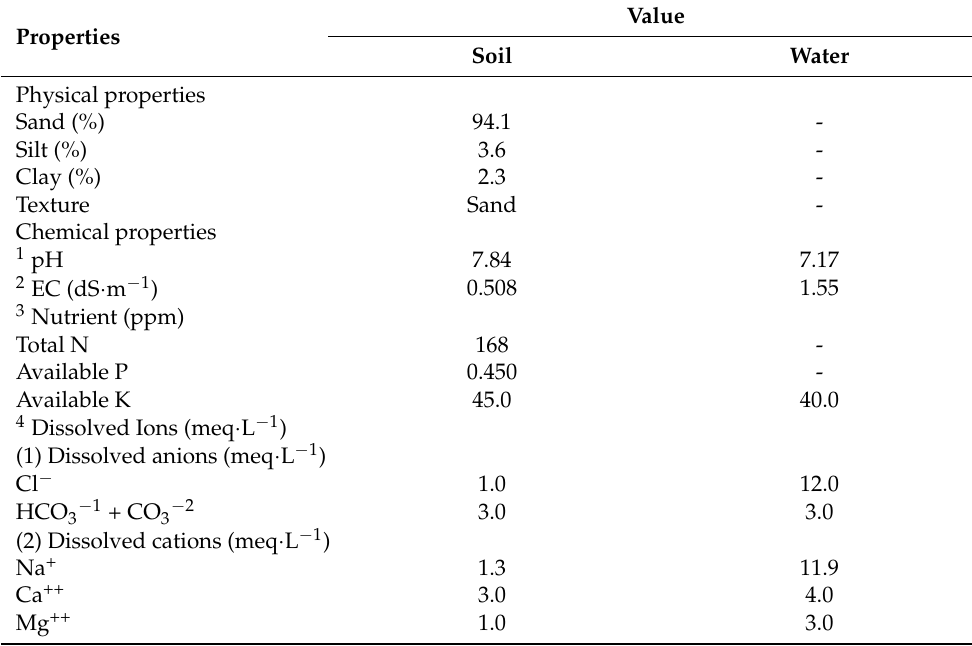
Table 5. Physical and Chemical Properties of Soil and Water used for the